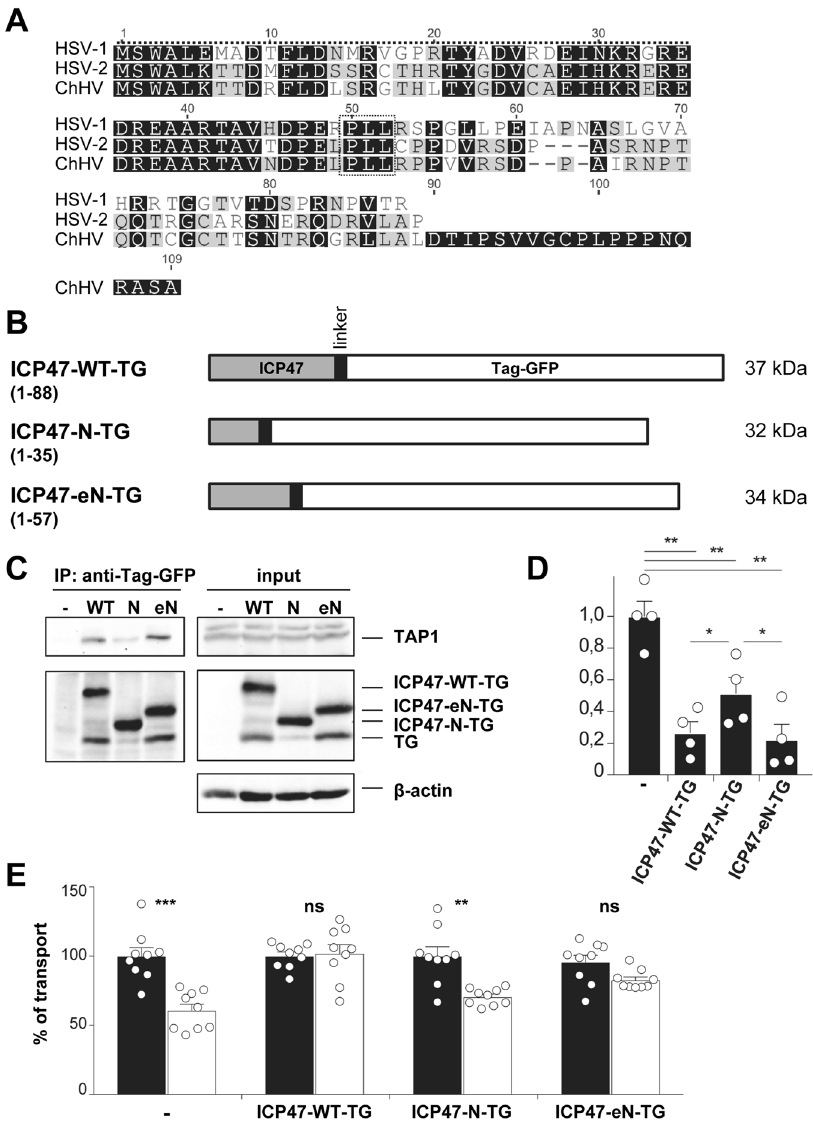
Figure 1. The ICP47 residues 1–35 are not sufficient for efficient inhibition of TAP. ( A ) Sequence alignment of ICP47 sequences from HSV-1, HSV-2 and chimpanzee alpha-1 herpesvirus (ChHV). Identical amino acids are shown in black. The dotted lines indicate the residues 1–35, that were shown to be sufficient for TAP inhibition 29, 30 . The highly conserved residues 50–52 are marked with a box. ( B ) Schematic depiction of ICP47-TagGFP fusion proteins with number of N-terminal ICP47 residues in front of the linker and TagGFP, and apparent protein sizes. ( C ) HeLa cells stably expressing fusion proteins shown in B were lysed in digitonin lysis buffer and an anti-TagGFP IP was performed. Aliquots of the lysates (input) and recovered proteins (IP) were separated by SDS-PAGE and detected by Western blotting (TAP1, 148.3; ICP47-TG fusion constructs, anti-TagGFP). One representative experiment out of three independent experiments is shown. Shown blots are cropped. Original blots are depicted in Fig. S3. The same procedure for presentation of blots has been used in all following figures. ( D ) Cells from C were analyzed by FACS using W6/32 mAbs for surface expression analysis. The diagram shows relative MFI values compared to control cells ( − ). The error bars indicate the standard error of mean, the circles indicate individual samples derived from independent experiments (unpaired student t -test, * p ≤ 0.05, ** p ≤ 0,001 n = 4). ( E ) HeLa cells stably transduced with ICP47-TG constructs were semi- permeabilized with streptolysin O (SLO) and a peptide translocation assay was performed with a fluorescent peptide (5 nM of NST-Cy5) and either ATP (black bars) or ADP (white bars) (10 mM each). Cells were analyzed by flow cytometry for Cy5 mean fluorescence intensity (MFI). The mean MFI value of untransduced Hela cells with ATP was set as 100% and used to calculate relative translocation for all samples (shown as % of transport). The error bars indicate the standard error of mean, the circles indicate individual samples of 3 independent experiments (Kruskal-Wallis test with Dunn’s correction for multiple comparison, ** p ≤ 0.007, *** p ≤ 0,0008 n =